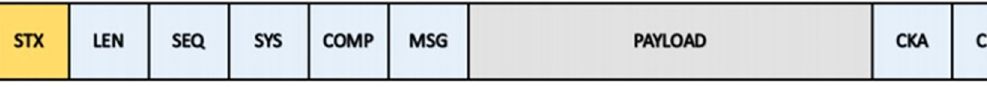
Figure 4: The structure of MAVLink command.